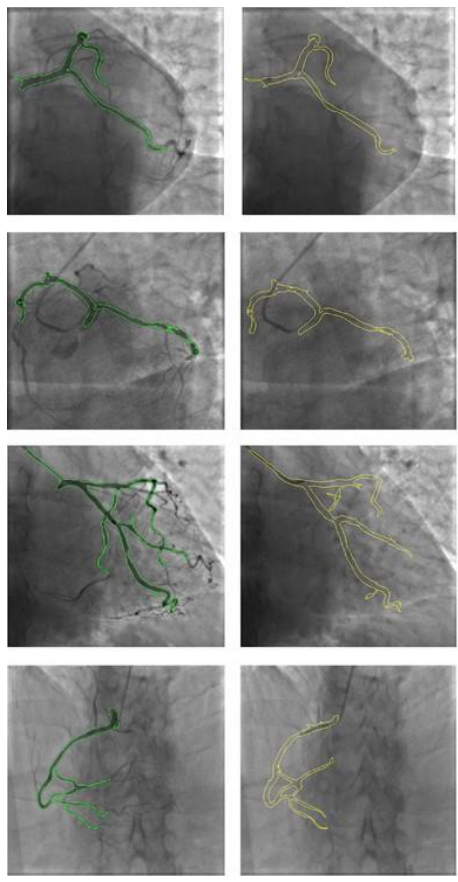
Figure 3. Exemplary frames showing side by side the results of CoroFinder-mediated prediction of vessel position in the right column (the yellow contour indicates the predicted location of the coronary artery) and the segmented contours from standard contrast-enhanced angiograms in the left column (the green contour lines indicate the location of coronary arteries as determined by contrast dye presence). The panel includes three angiographic projections of the left coronary artery: antero-posterior caudal view (first row), left anterior oblique caudal view (second row), right anterior oblique caudal view (third row), and a single angiographic projection of the right coronary artery: left anterior oblique view (fourth row).